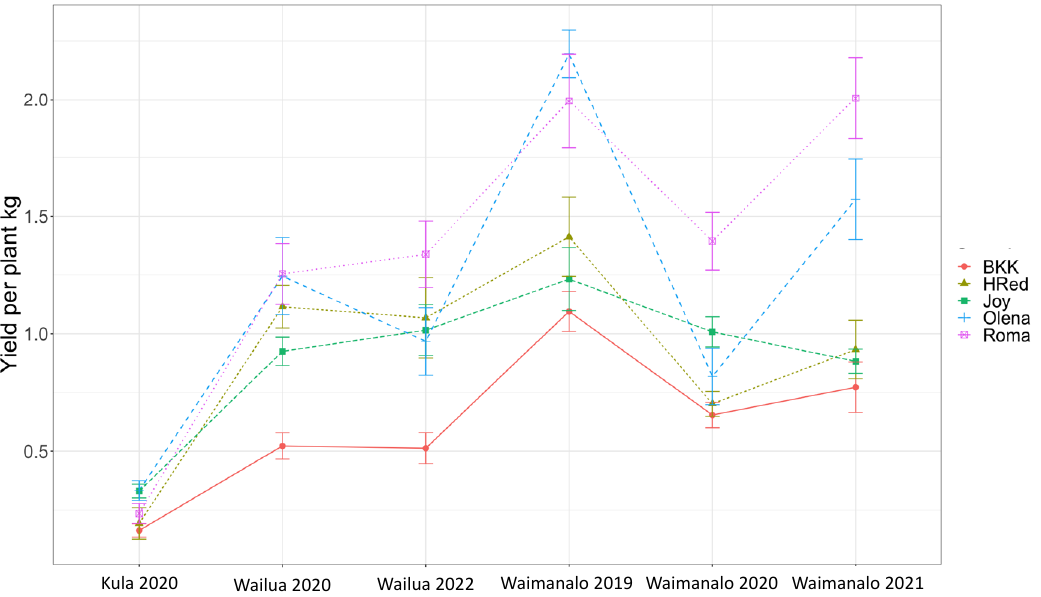
Figure 1. Interaction plot of yield (kg fingers per plant) of cultivars commonly planted at six different site/year combinations. Data were analyzed as a split plot with site/year as the main plot and genotype as the split plot. Data point are means (N = 4) with standard error bars representing variation.